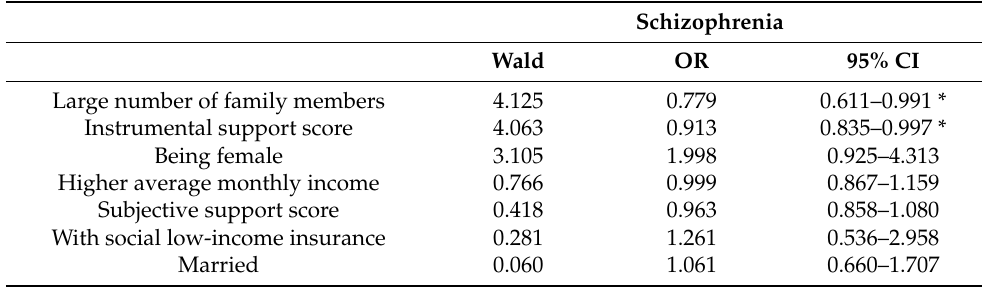
Table 3. Multivariate logistic regression of influencing factors associated with having family going out for